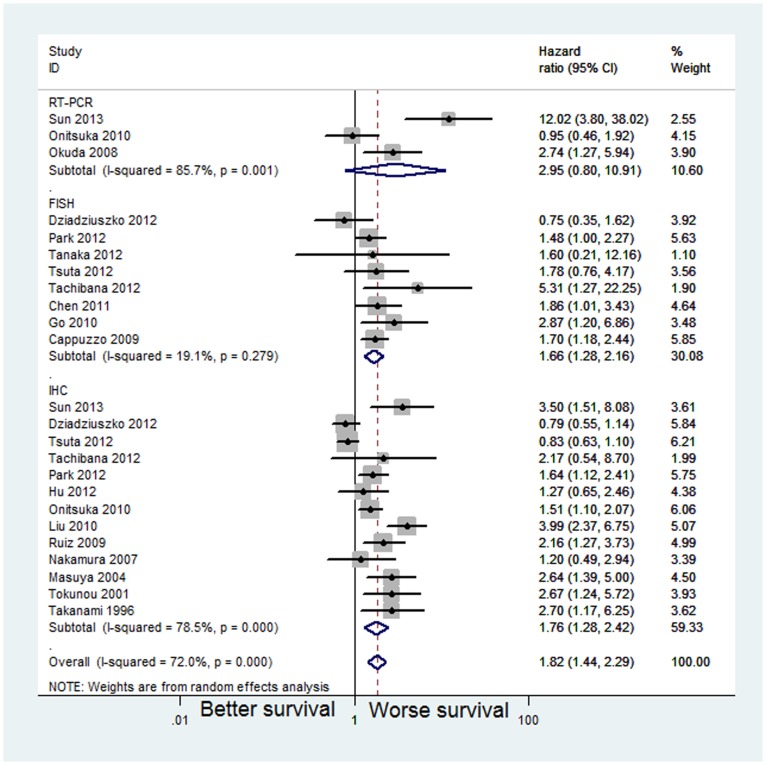
Meta-analysis that according to different methods of MET detection used.